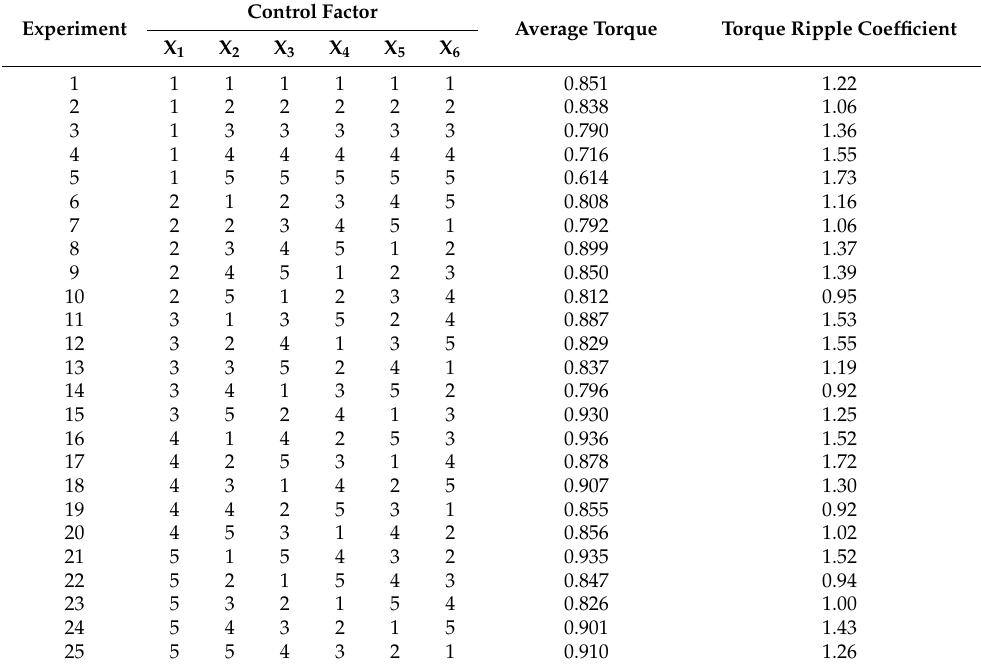
Table 3. Taguchi orthogonal array L 25 (6 5 ) for 6 control factors and 5 levels and simulation